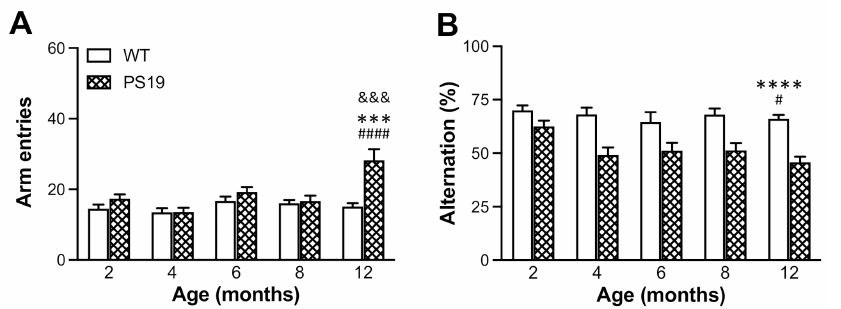
Figure 4. Mean ( ± SEM) total number of arm entries ( A ) and percentage of spontaneous alternation ( B ) of male wild-type (WT) and PS19 mice at 2, 4, 6, 8 and 12 months of age in the Y-maze test ( n = 11–15/genotype/age). &&& indicates a significant genotype and age interaction at p < 0.001. * indicates a significant genotype effect at *** p < 0.001 or **** p < 0.0001. # indicates a significant age effect at # p < 0.05 or #### p <